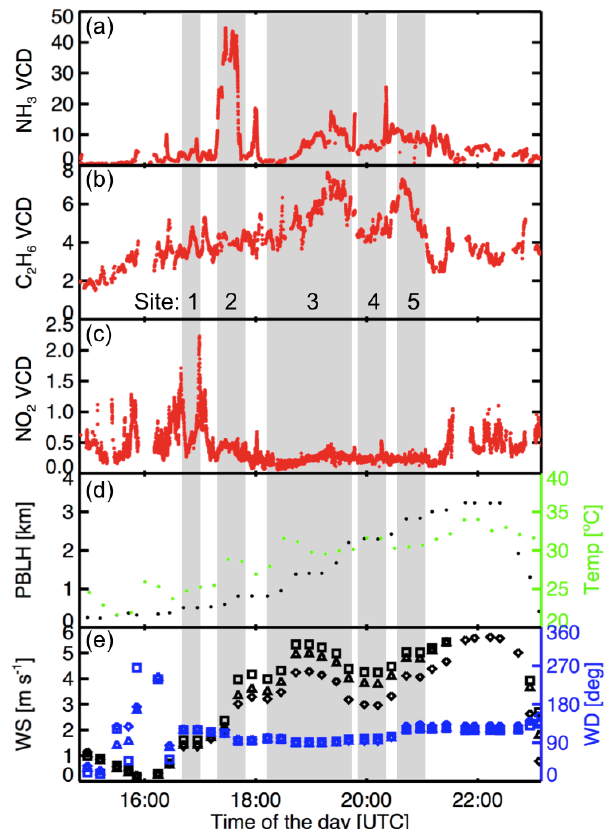
Figure 7. Time series of the VCDs (10 16 moleccm − 2 ) measured for (a) NH 3 , (b) C 2 H 6 and (c) NO 2 during RD11. (d) PBLH and temperature. (e) Model wind speed and model wind direction aver- aged over approximately 10–50m above ground level (diamonds), over half PBLH (triangles) and over the full PBLH (squares). Shaded areas indicate times at each site (numbers correspond to those in Fig.